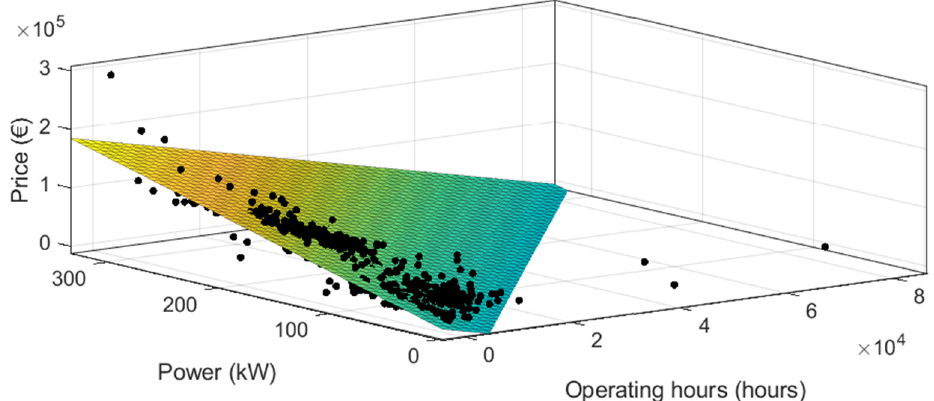
Figure 21. Price vs. power and operating hours for second-hand tractors.